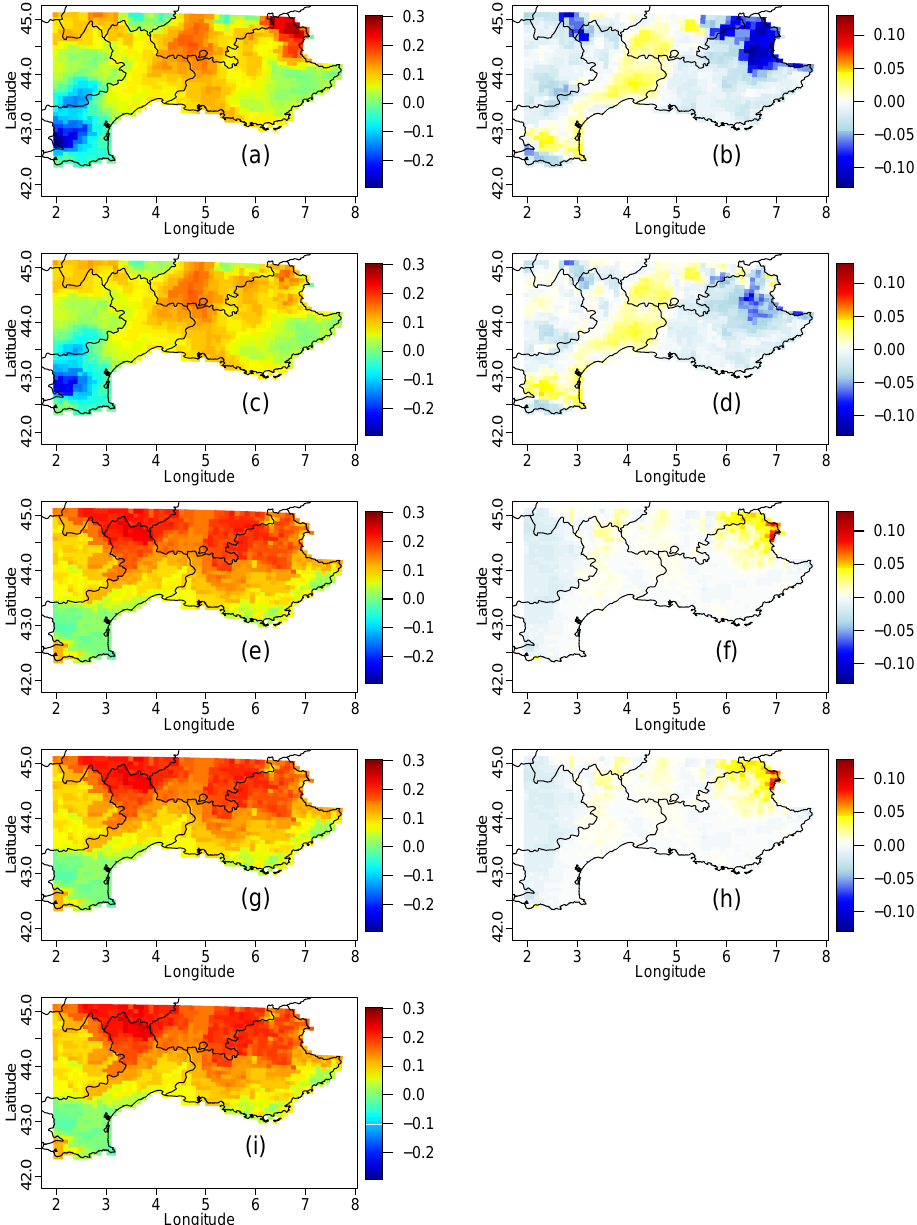
Figure 9. (left column) Inter-variable Pearson correlations between T2 and PR in winter for each grid cell and (right column) changes in inter- variable Pearson correlations from the historical period to the 2071-2100 period; (a–b) for the WRF RCM; (c–d) for its 1d- bias correction with CDFt; (e–f) for its 2d-R 2 D 2 correction; (g–h) for its 3012d-R 2 D 2 correction. Panel (i) corresponds to the correlations between T2 and PR for the SAFRAN reference data over the historical